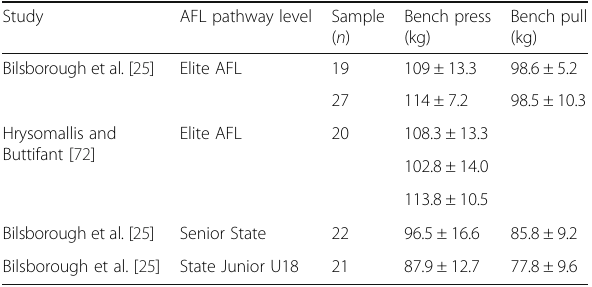
Table 2 Reported strength performance measures reported for level of AFL participation pathway. Measures represented as mean ± standard deviation